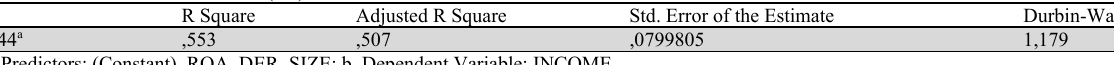
Coefficient of Determination (R 2 ) Results